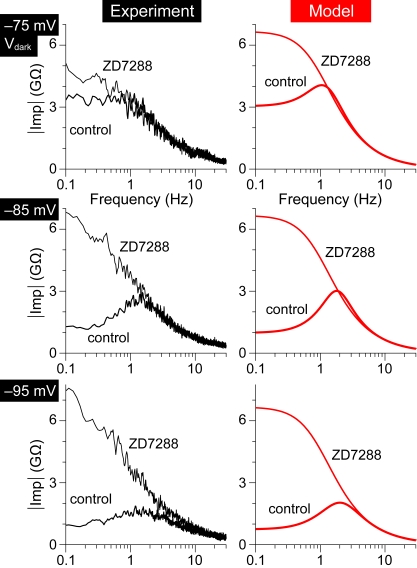
Blocking Ih converts the impedance profile of RBCs from band–pass to low–pass.
Left column, Impedance profile of an RBC measured at Vdark, Vdark−10 mV and Vdark−20 mV in control and during a nearly complete blockade of Ih with 1 µM ZD7288. At −85 mV and −95 mV ZD7288 greatly enhanced the cell's response to low–frequency input, converting its behavior from band–pass to low–pass one. This effect was less prominent but also present at the −75 mV (Vdark). Impedance profiles obtained from average of 4–9 sinusoidal response sweeps. Right column, Impedance profiles predicted by a simplified model of the same RBC (see Figure 3C, legend) match rather well the experimental ones, except at −75 mV in ZD7288. The mismatch at this potential may be due to some activation of the current behind the upper range of band–pass behavior (cf. Figure 3D). ZD7288 was simulated by setting Gh to zero. Detailed parameters used in modeling this cell were Gh = 0.395 nS, V0.5 = −90.5 mV, km = 5.5 mV, taumax = 330 ms, Gleak = 0.150 nS, C = 25 pF.